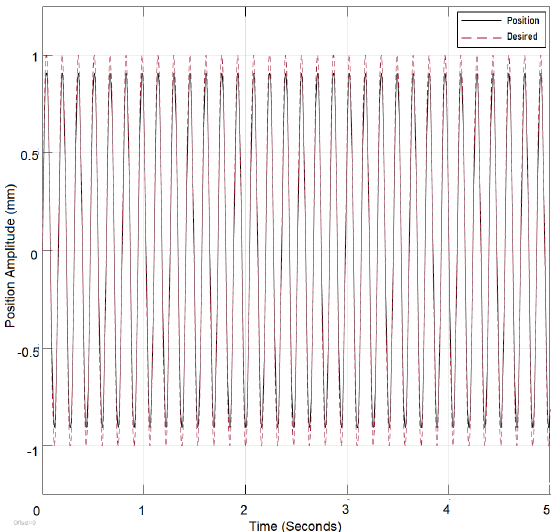
Figure 7. PID controlled position with reference to sinusoidal wave of 40 rad/s